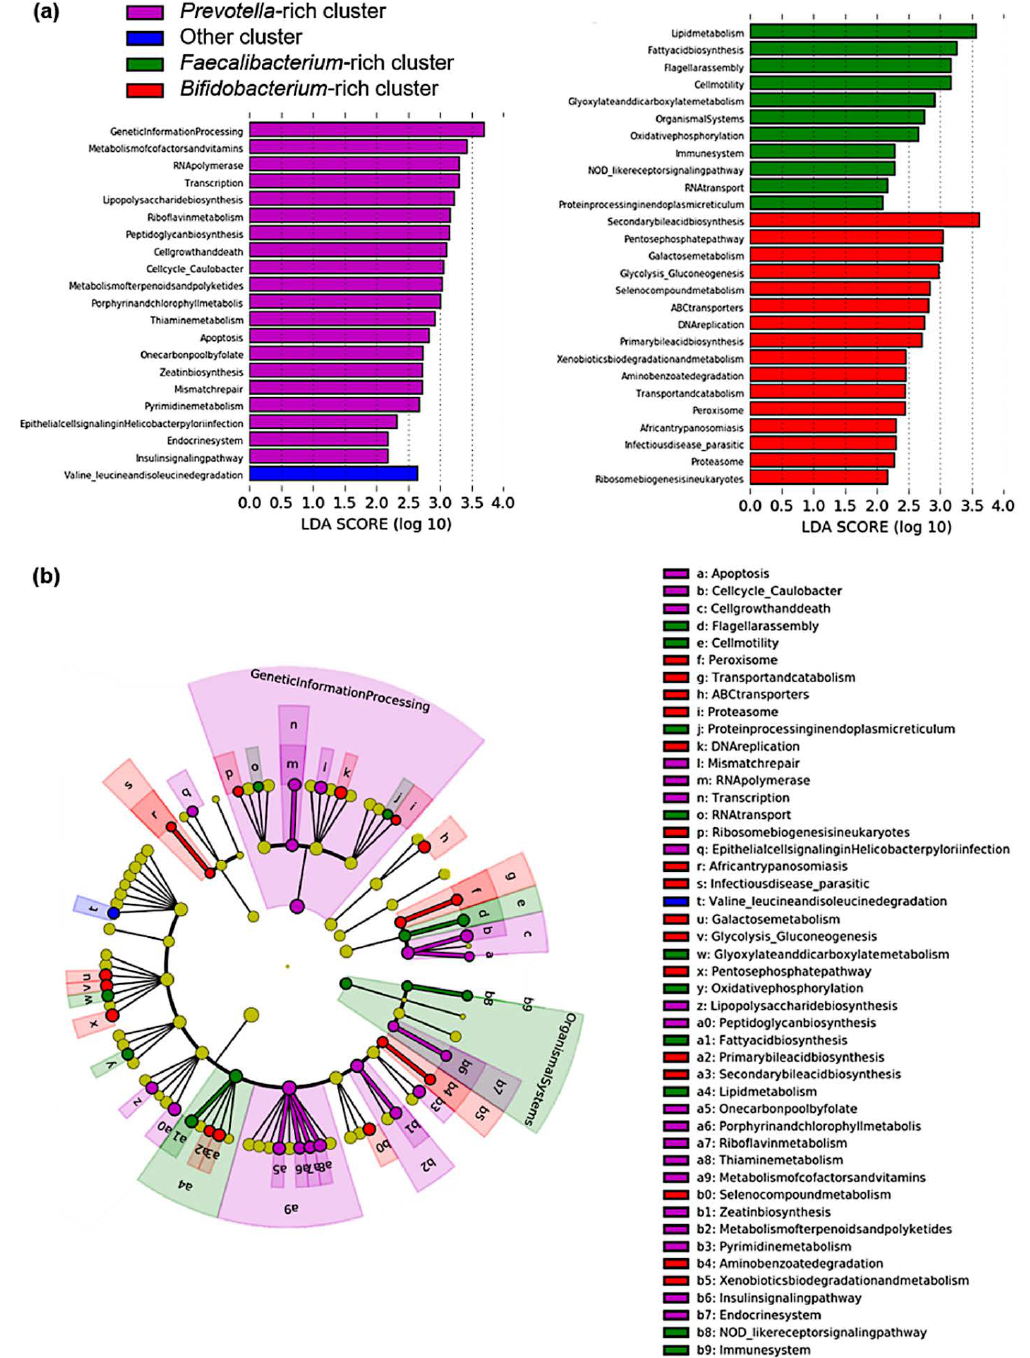
Figure 4. Pathway analysis based on identified clusters. Linear discriminant analysis effect size (LEfSe) analysis identified the assumed activated Kyoto Encyclopedia of Genes and Genomes (KEGG) metabolic pathways that characterized each cluster: ( a ) linear discriminant analysis (LDA) scores for identified metabolic pathways of the Prevotella -rich cluster (20 pathways), the Faecalibacterium -rich cluster (11 pathways), and the Bifidobacterium -rich cluster (16 pathways). Purple indicates Prevotella - rich cluster, blue indicates “Other” cluster, green indicates Faecalibacterium -rich cluster, and red indicates Bifidobacterium -rich cluster; ( b ) cladogram of LEfSe analysis results. This is a circular tree diagram representing the hierarchical categories of KEGG metabolic pathways, with each yellow dot representing a pathway identified in this analysis. The regions that characterize each cluster are shaded with the color of the